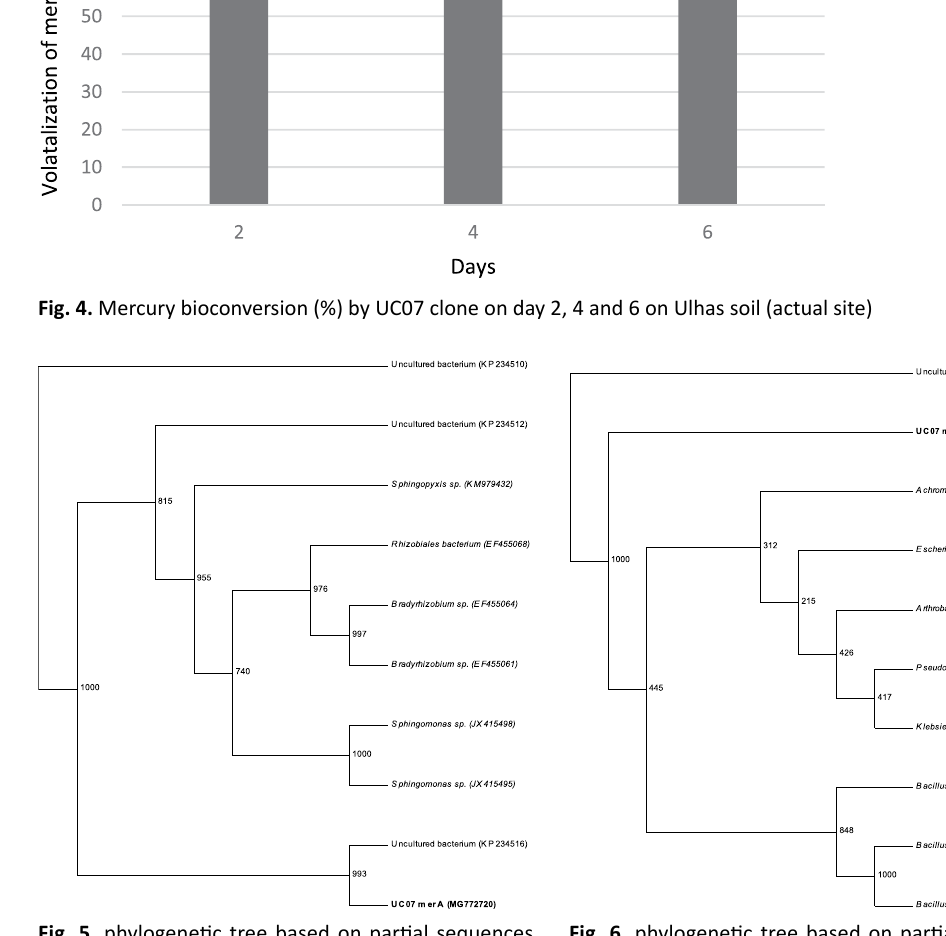
Fig. 5. phylogenetic tree based on partial sequences of mer A genes was produced applying the Neighbor- Joining method. The bootstrap values, calculated from 1000 replicates, show the percentage of replicate trees in which the associated ratio clustered together.